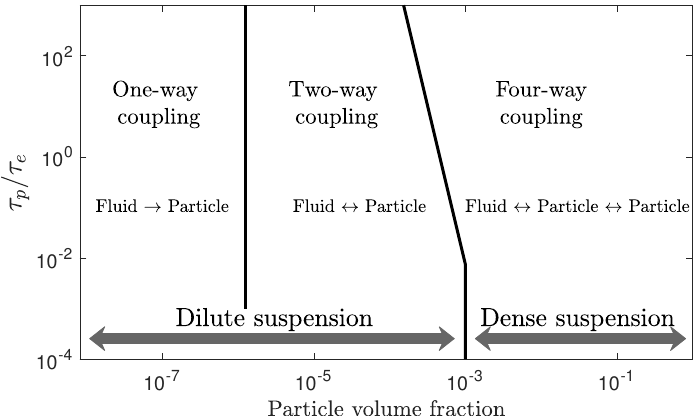
Figure 4. Map of gas–solid interaction regimes of particle-laden turbulent flows. τ p and τ e are the particle kinetic response time and time-scale of large eddies in a turbulent flow, respectively. Reproduced with permission from S. Elghobashi, On predicting particle-laden turbulent flows; published by Springer Nature, 1994